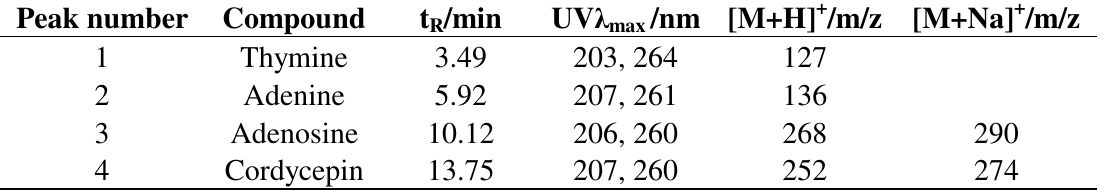
, UV λ ,[M+H] + and other MS ions of nucleoside standard R max